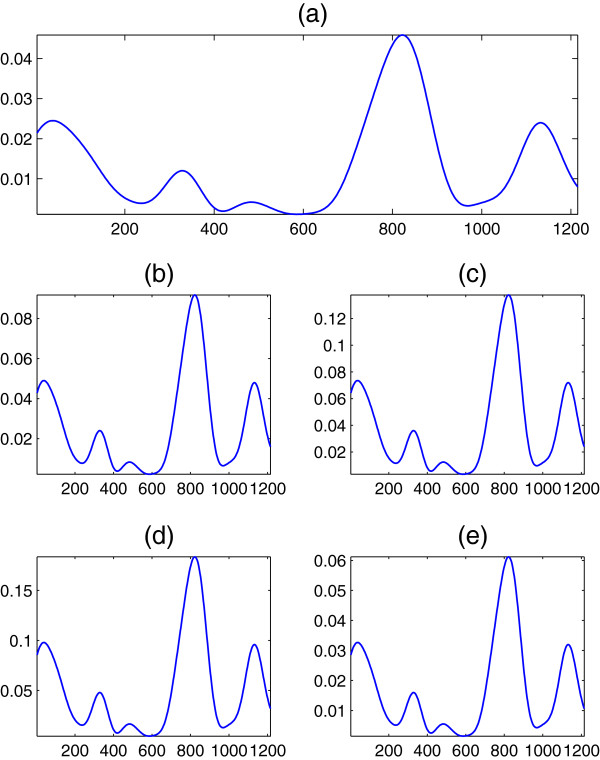
DNA spectrumS~d(n)withh~set to a Blackman window at
R
= 3 of the DNA sequence ECZGL2 when (a) Voss, (b) tetrahedral, (c) quaternion, (d)
Z
-curve, and (e) simplex mappings are used.